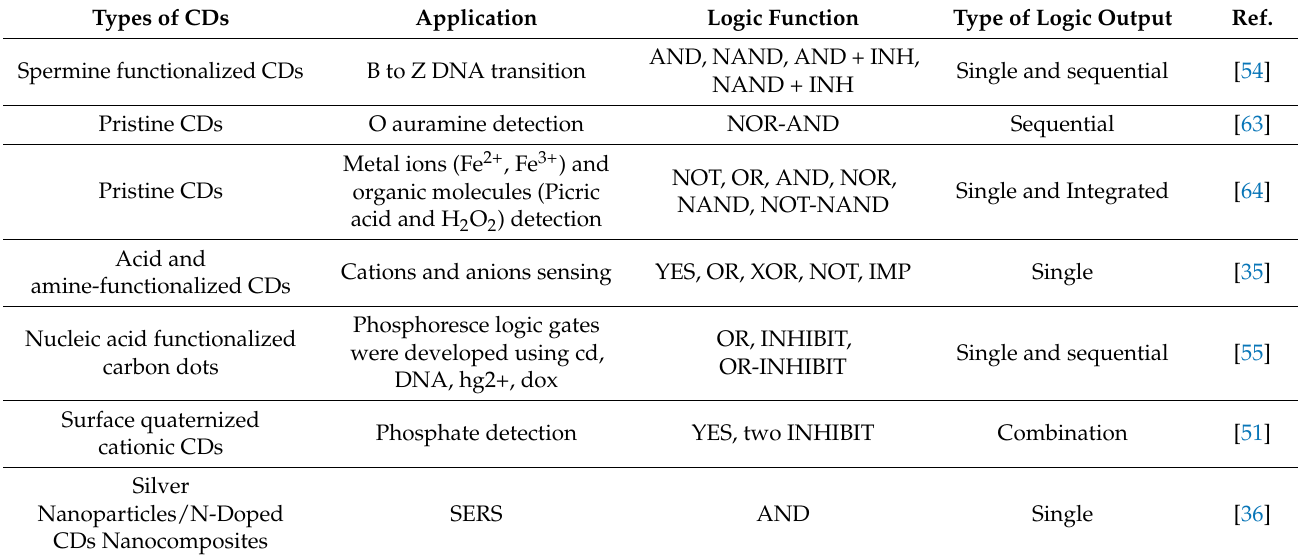
Table 1. Summary of CDs-based logic